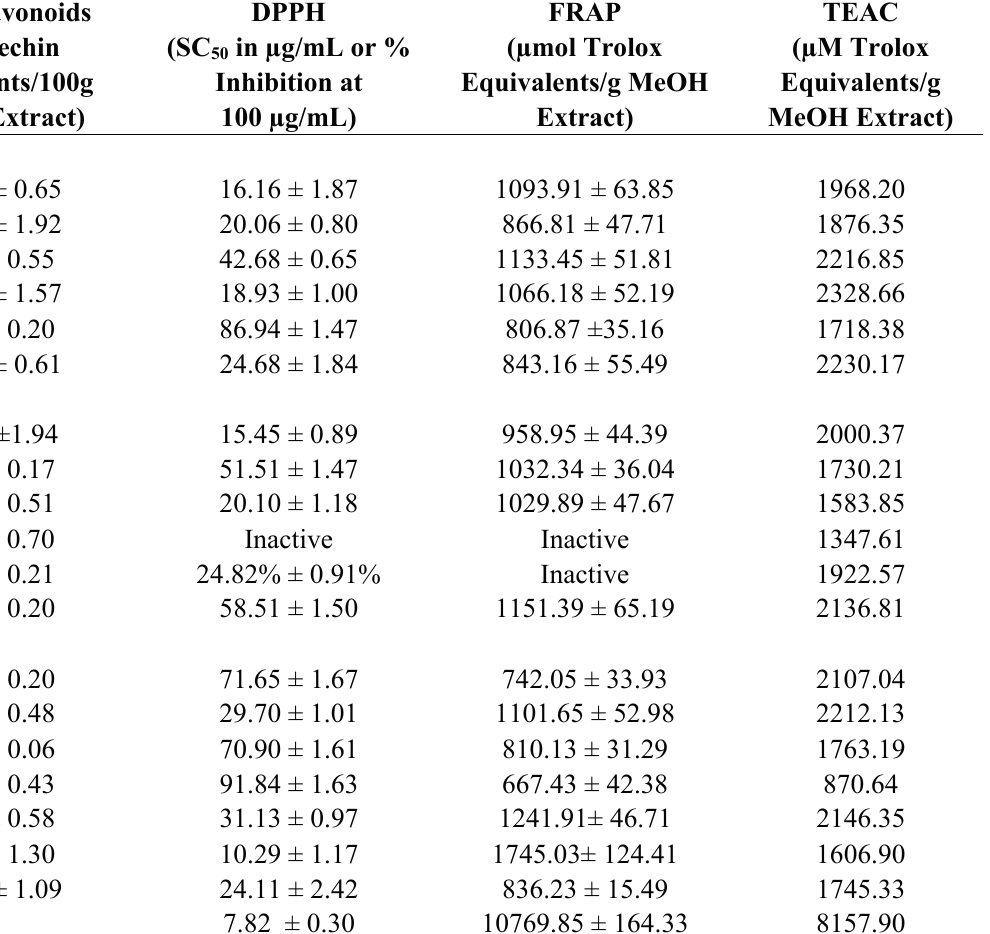
Determinations of TP, TF, DPPH and FRAP were performed in triplicate and results are expressed as mean values ± SD. For the TEAC assay, a curve was plotted for each sample and a correlation coefficient with a 95% confidence limit was